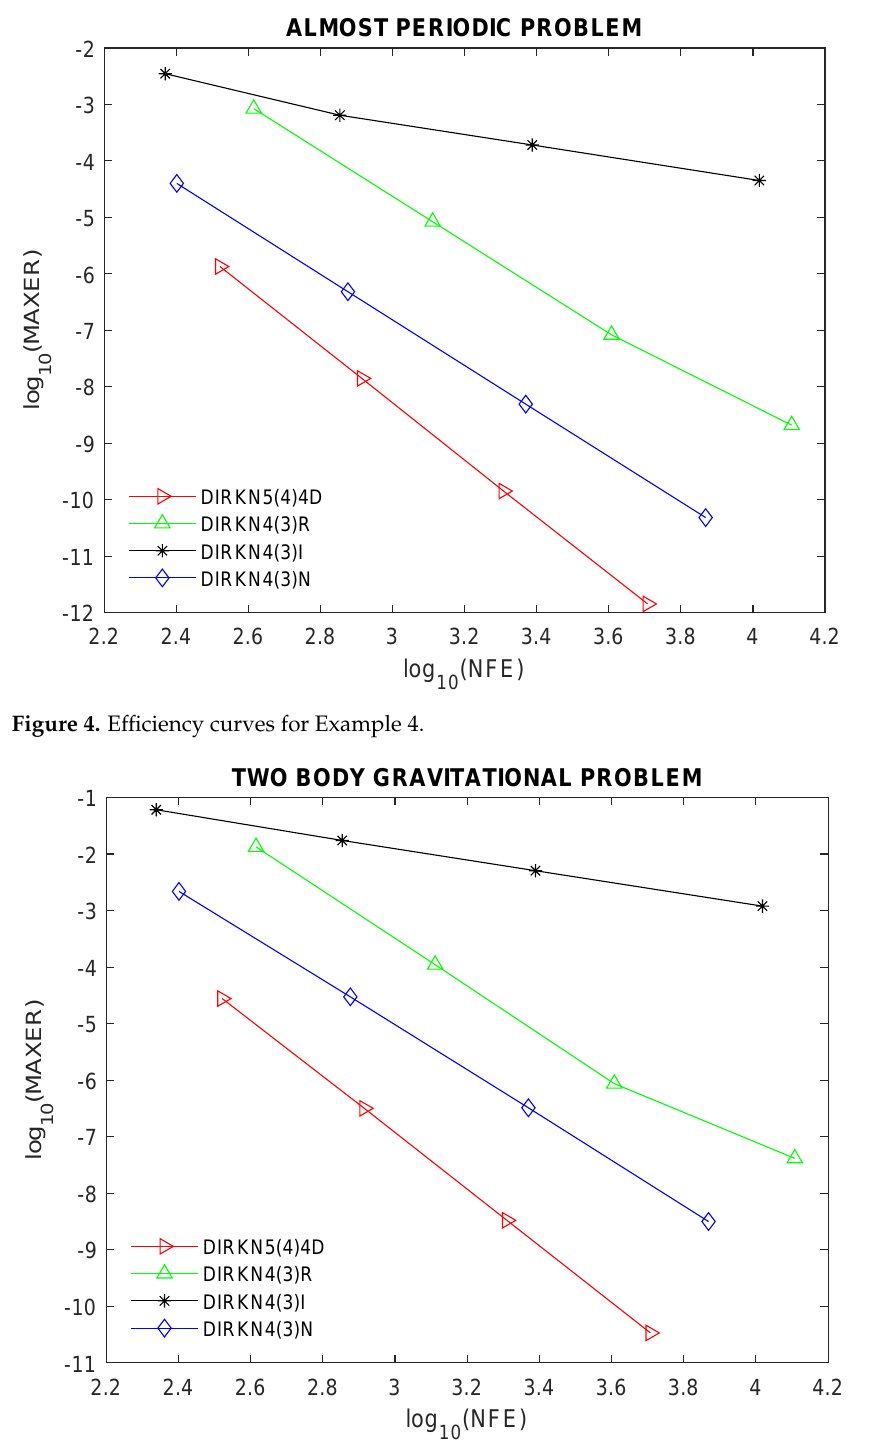
Figure 5. Efficiency curves for Example